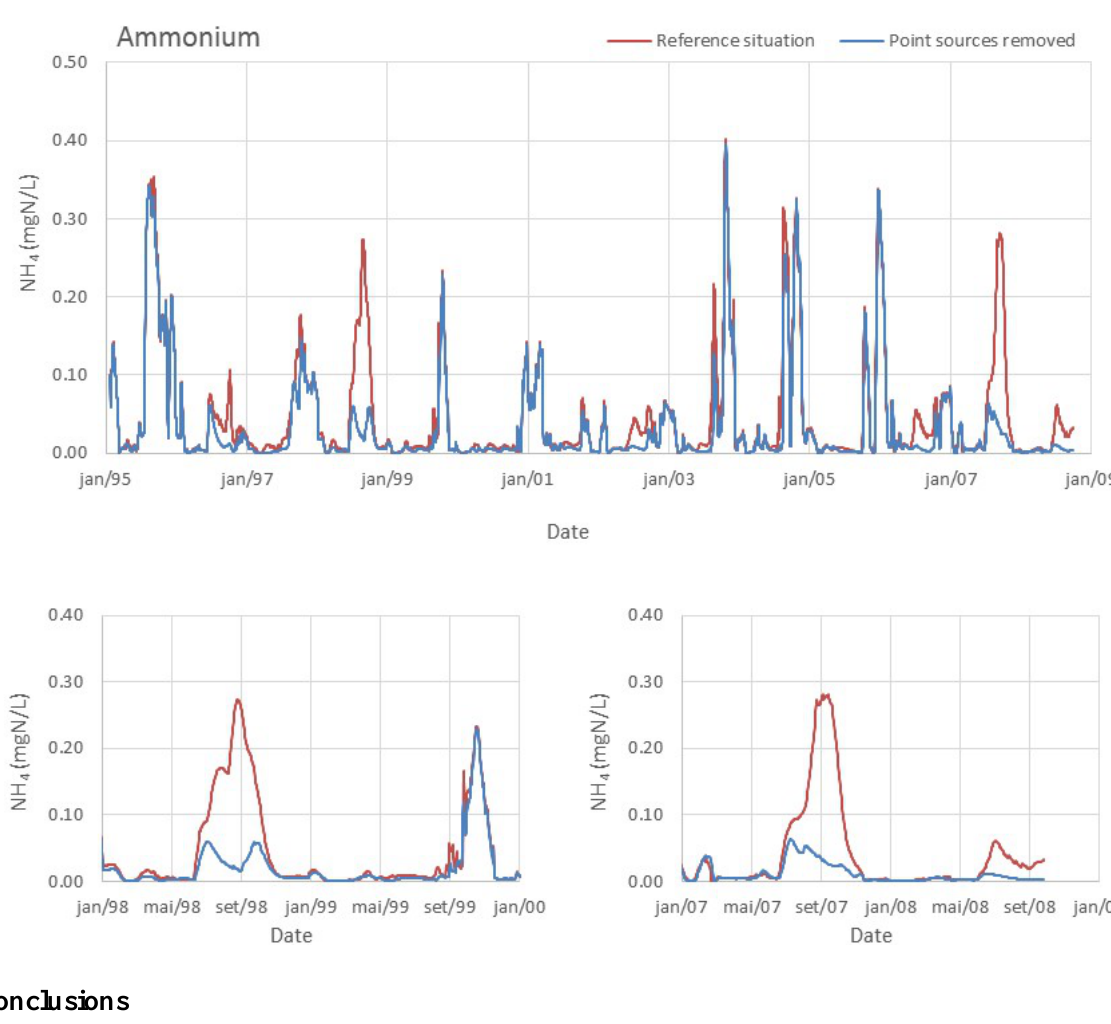
Figure 8. Model results for the reference situation and for the scenario where the point sources of nutrients have been removed. Lower panels show smaller periods to highlight differences in